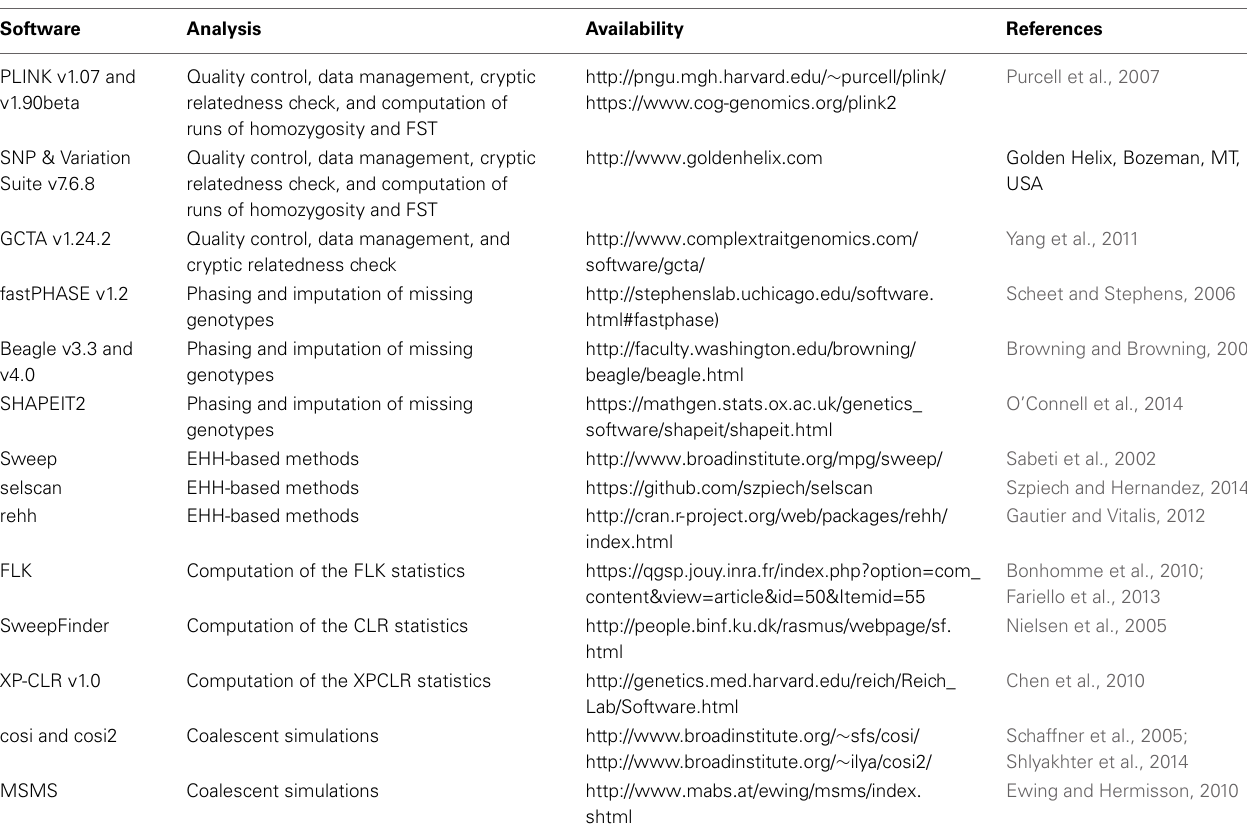
Table 1 | Available software for signatures of selection